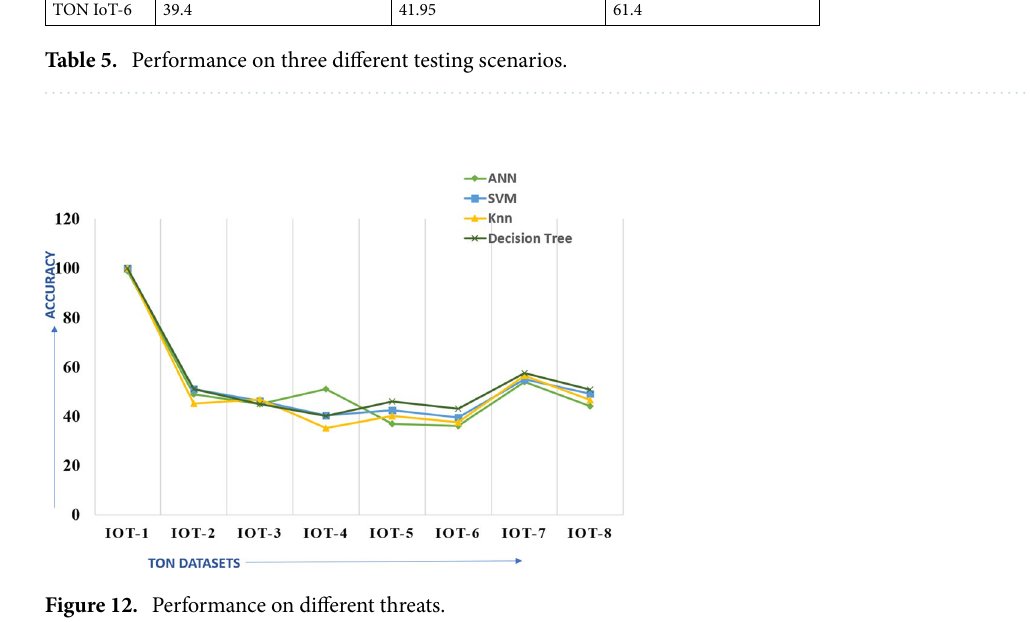
Figure 12. Performance on different